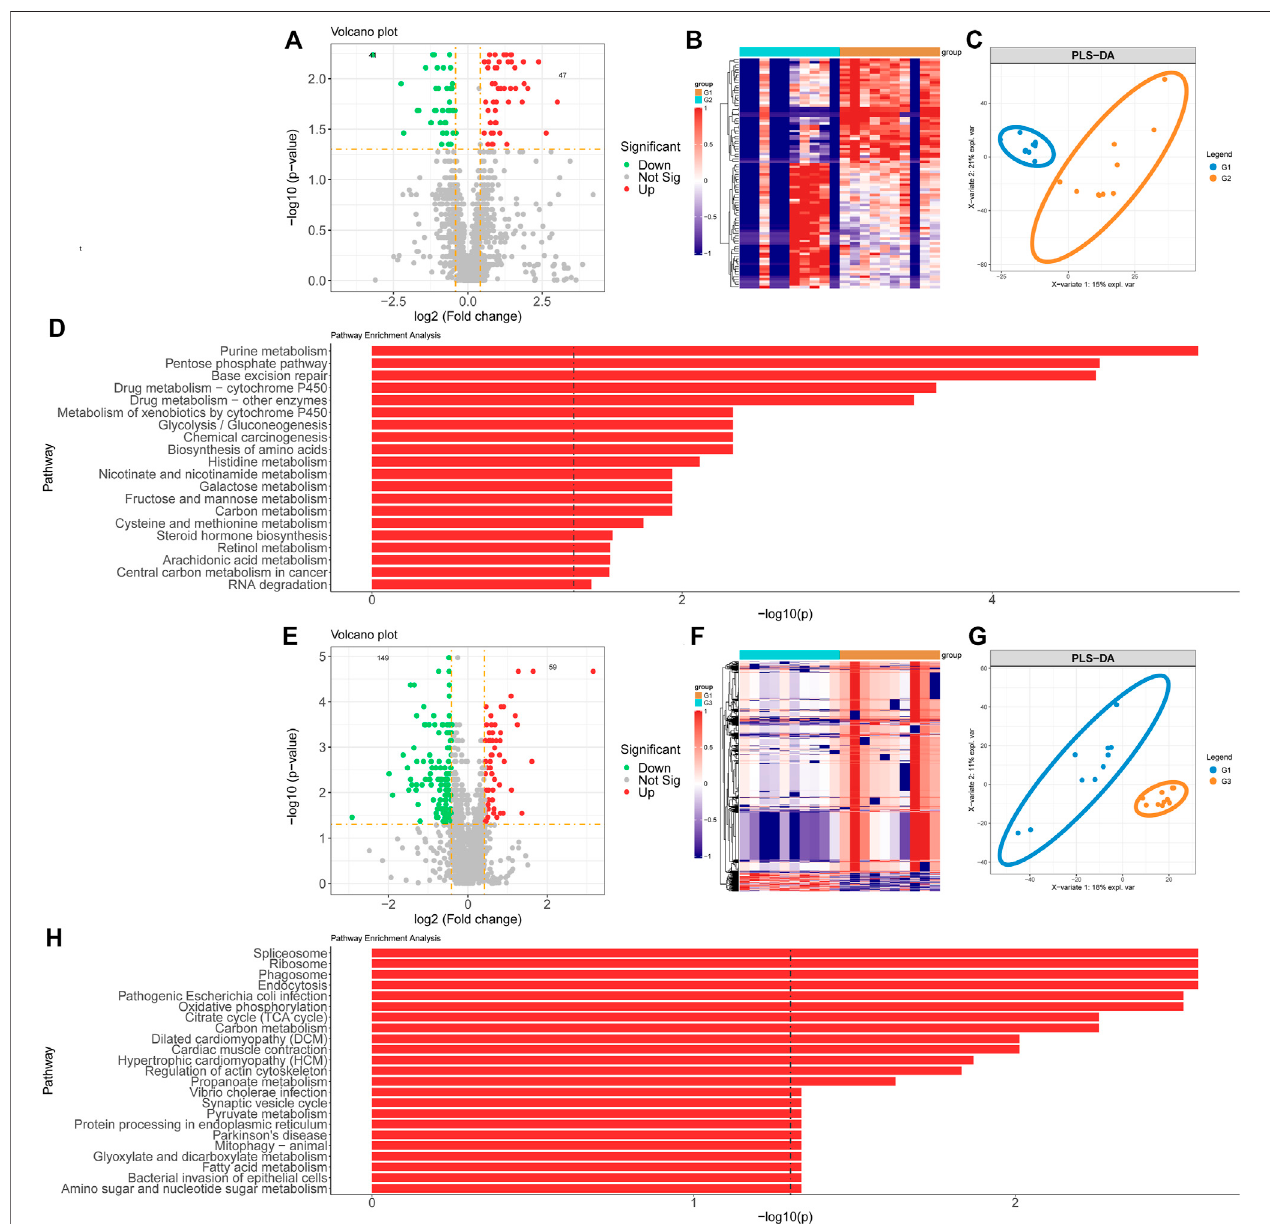
FIGURE2| Proteomicspro fi linganalysisofvalvularAFandnon-valvularAFsamples. (A,B) Thevolcanoplot (A) andheatmap (B) showedthedifferentlyexpressed proteins in valvular AF compared to SR samples. (C) PLSDA analysis showed the protein pro fi les between valvular AF and SR tissues. (D) KEGG analysis of differently expressedproteinsinvalvularAF. (E,F) Thevolcanoplot (E) andheatmap (F) showedthedifferentlyexpressedproteinsinnon-valvularAFcomparedtoSRsamples. (G) PLSDA analysis showed the protein pro fi les between non-valvular AF and SR tissues (H) KEGG analysis of differently expressed proteins in non-valvular AF.